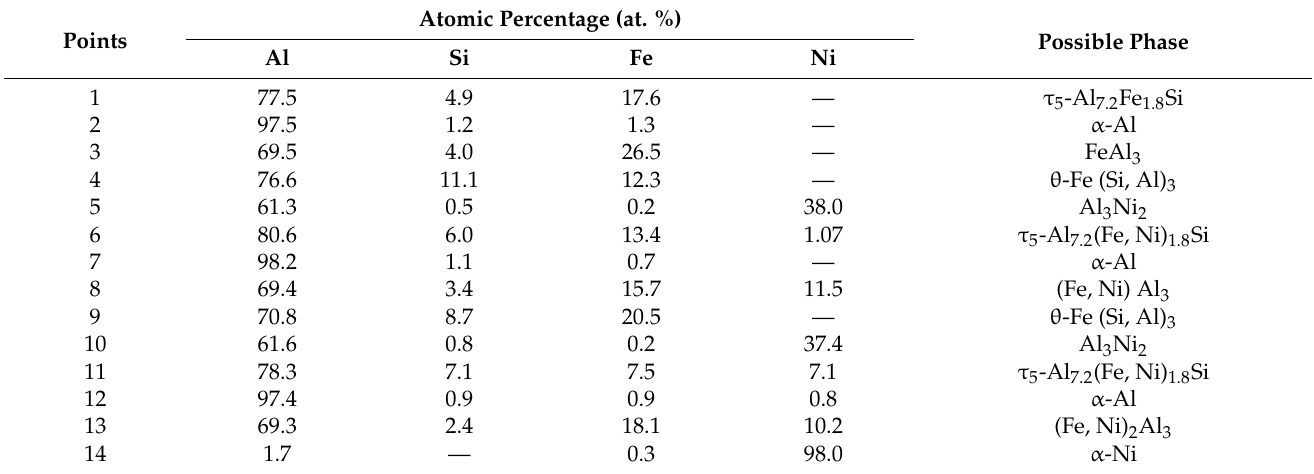
Table 3. The EDS points scanning results and possible phase of corresponding characteristic points in Figure